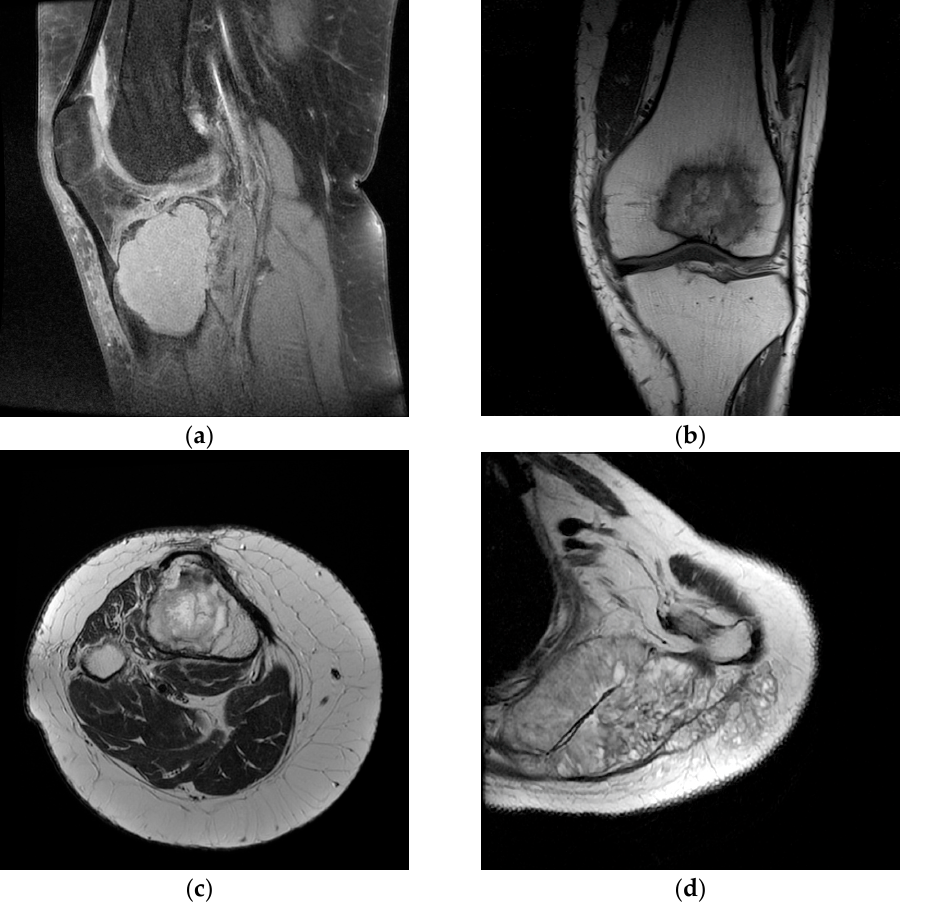
Figure 1. Sample images from the dataset used in the study. ( a ) Benign tumor T1 FS weighted image; ( b ) malignant tumor T1 weighted image; ( c ) benign tumor T2 weighted image; ( d ) malignant tumor T2 weighted image.